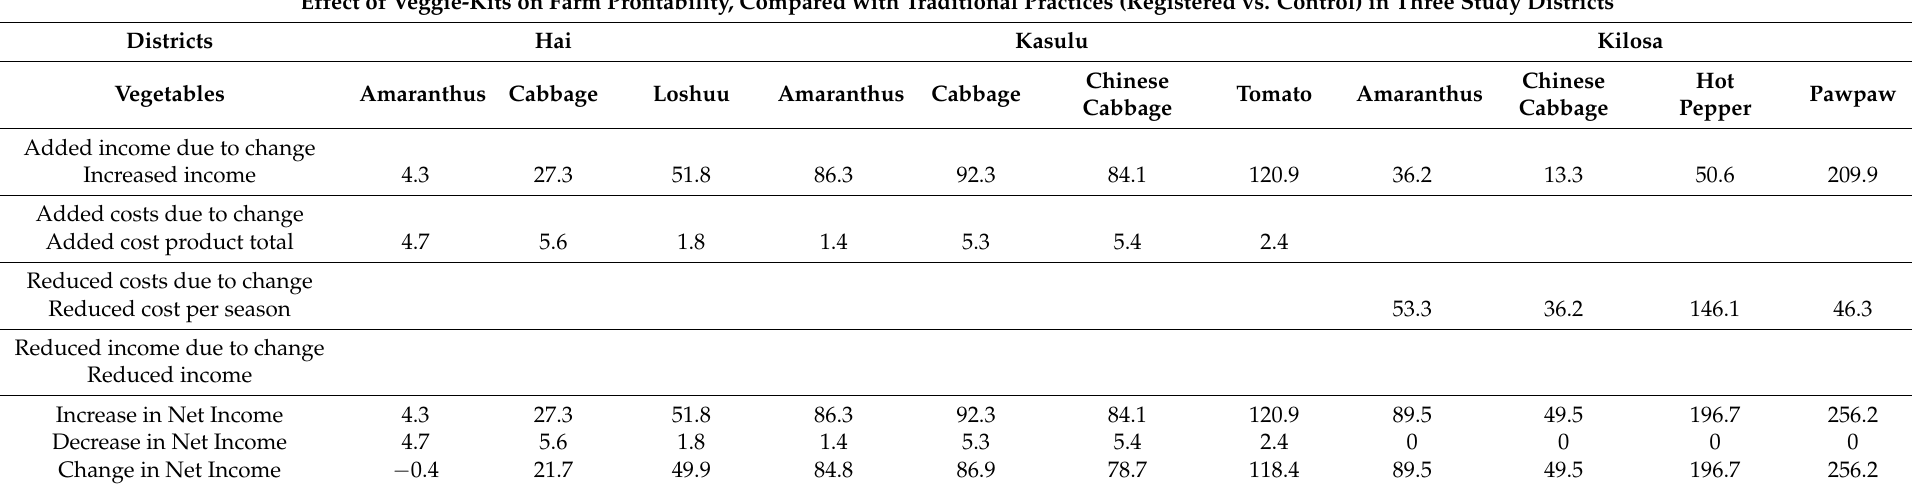
Table 3. Partial budgeting analysis of selected vegetables grown by both MI and control group farmers (in Tanzanian shilling) in three study districts in Tanzania. (Numbers are in 1000